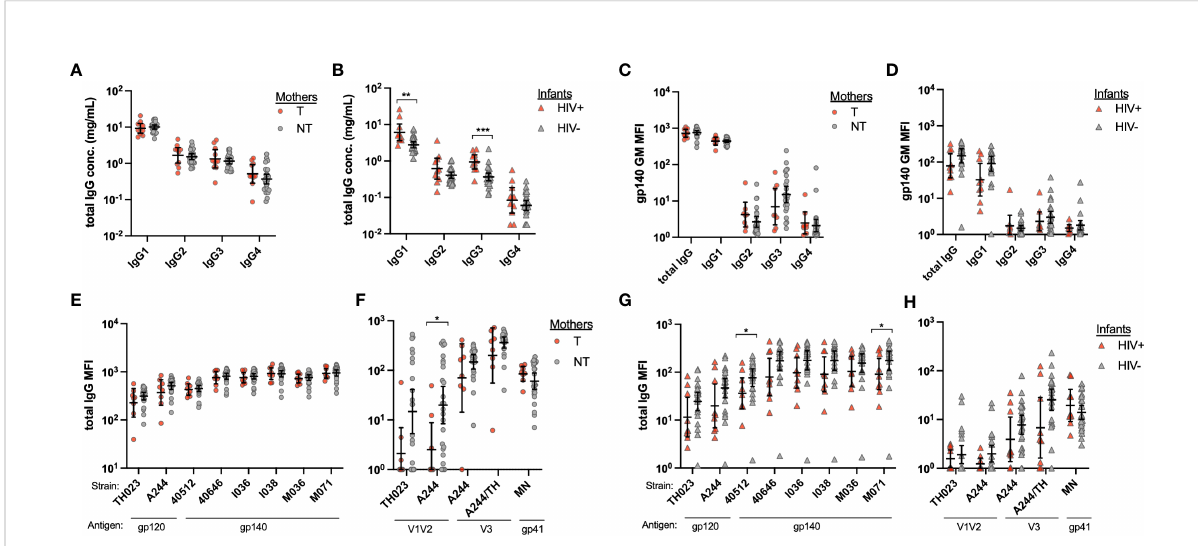
FIGURE 2 Mother and infant plasma total IgG and HIV antigen-speci fi c IgG. Total IgG1-4 were measured from plasma from (A) transmitting (T) and non- transmitting (NT) mothers and (B) HIV+ and uninfected (HIV-) infants by IgG subclass ELISA. HIV antigen speci fi c IgG was evaluated by Luminex multiplex assays using multiple HIV Env antigens and anti-IgG subclass as secondary antibodies. The geometric mean of the mean fl orescence intensity (MFI) for six gp140 proteins was determined for (C) mother and (D) infant total IgG and IgG subclasses 1-4. Total IgG binding of plasma from mothers (E , F) and infants (G and H) to speci fi c HIV antigens is shown for Env (E , G) and Env domains (F , H) . Signi fi cant differences were determined by Mann-Whitney test and are indicated by * above the plots; * = p < 0.05, ** = p < 0.005, *** = p <